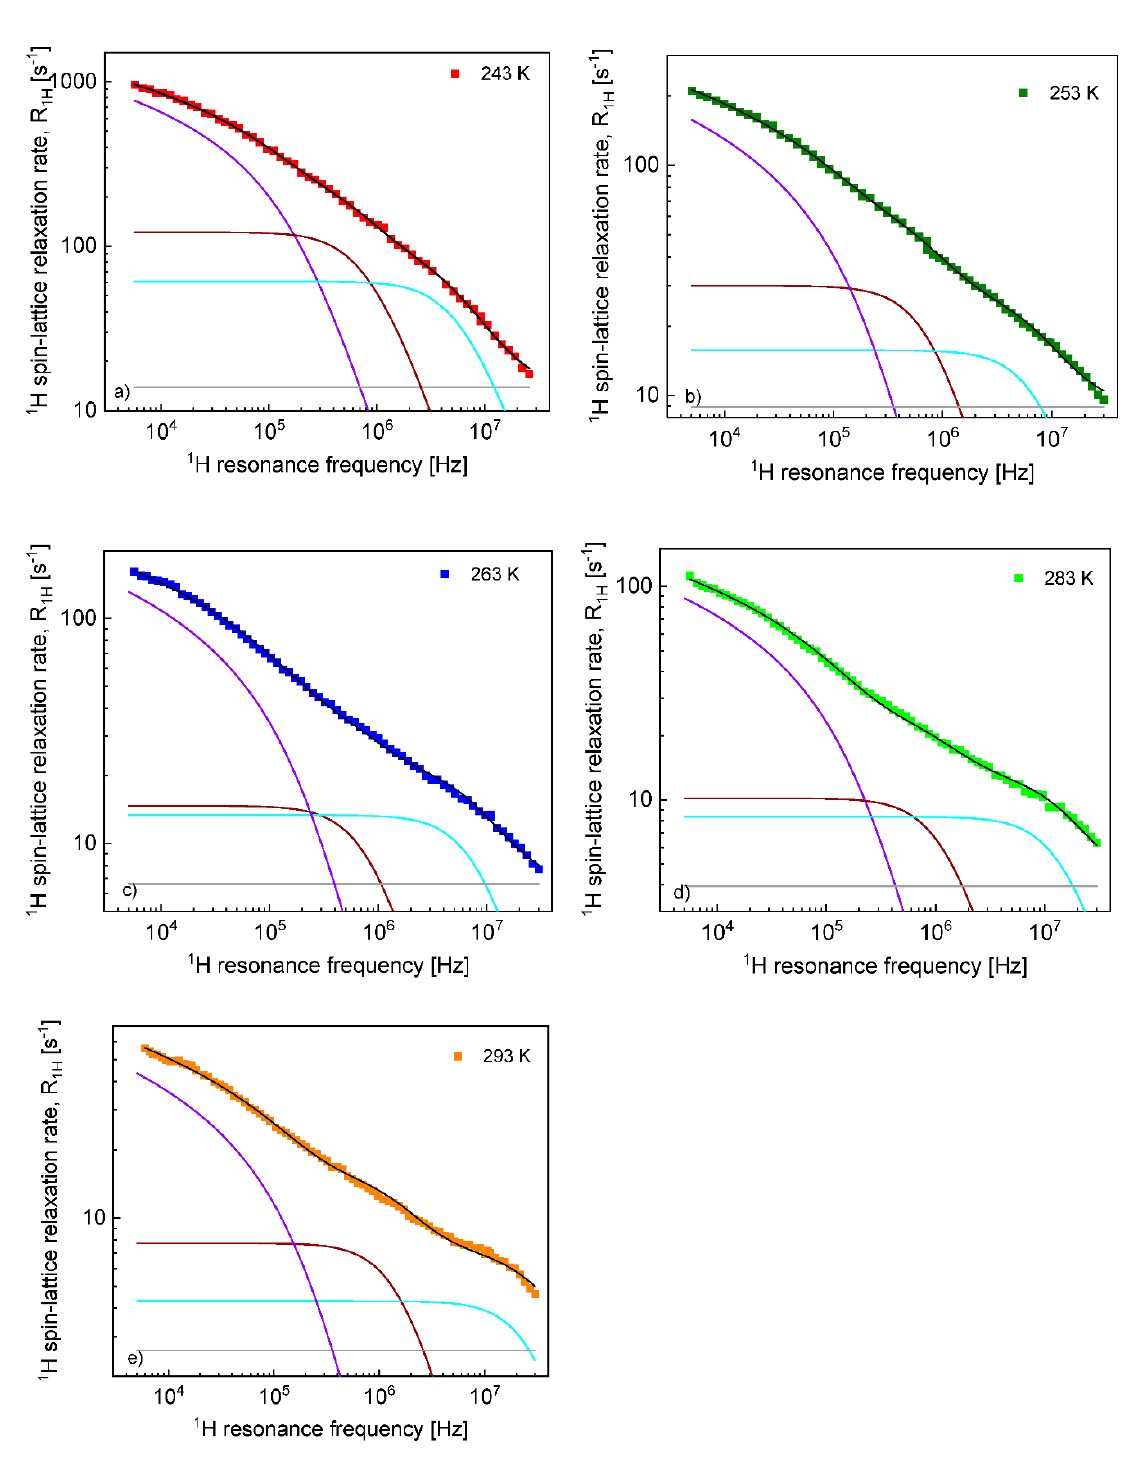
Figure 7. 1 H spin–lattice relaxation data for EMIM-FSI in the confinement at ( a ) 243 K, ( b ) 253 K, ( c ) 263 K, ( d ) 283 K and ( e ) 293 K: 𝑅 1𝐻𝑐𝑜𝑛𝑓 — black line; 𝑅 1𝐻𝑡𝑟𝑎𝑛𝑠,𝑐𝑜𝑛𝑓 —violet line; 𝑅 1𝐻𝑟𝑜𝑡,𝑐𝑜𝑛𝑓,𝑠 —brown line; 𝑅 1𝐻𝑟𝑜𝑡,𝑐𝑜𝑛𝑓,𝑓 —light blue line; and 𝐴 𝐻 —grey line.